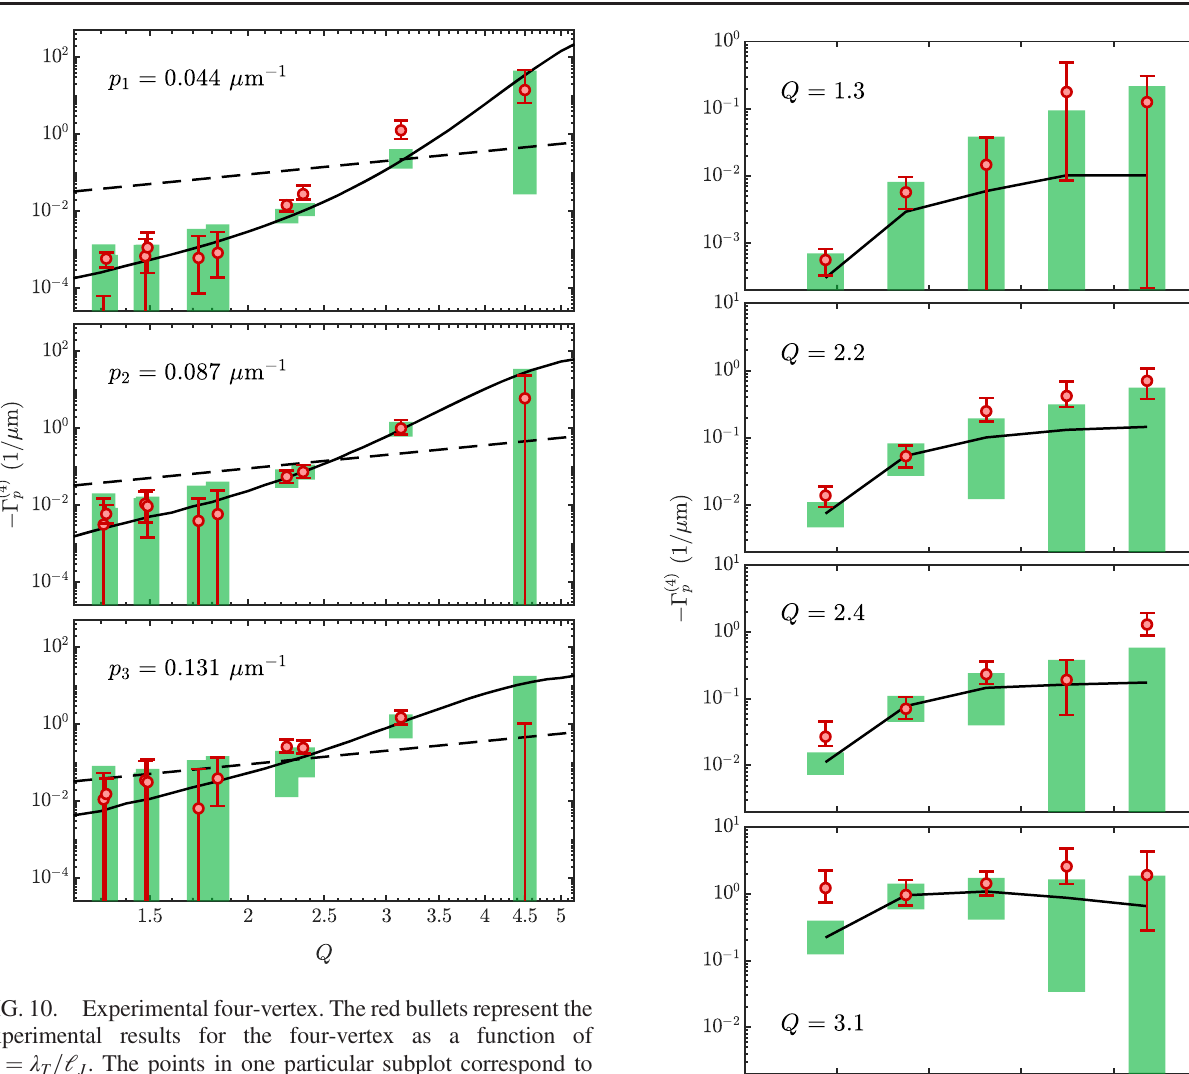
FIG. 11. Running coupling. Like Fig. 10, but showing Γ ð function of p for the four measurements with the biggest experimental sample size. Depending on the value of Q indicated in the different subplots, one can see a clear momentum dependence, i.e., “ running coupling. ” Note that the vertical axis of the uppermost subplot is different from the rest. However, the logarithmic range is the same as in the other